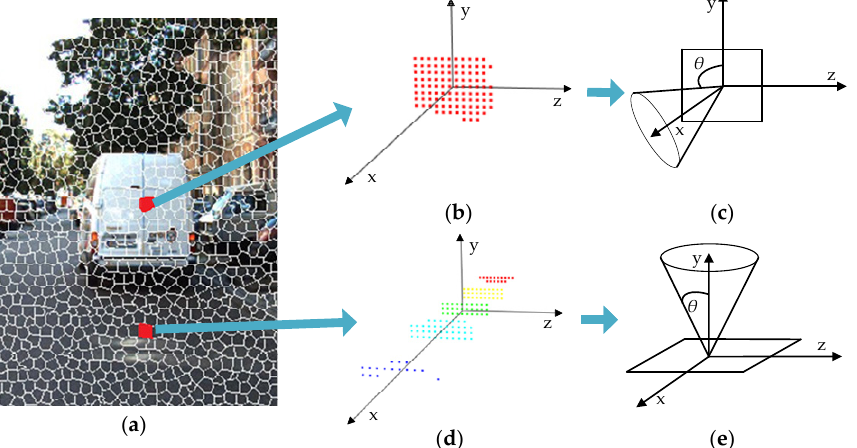
Figure 4. Comparison of point cloud distribution between obstacle and free space area: ( a ) Typical traffic scene; ( b ) Superpixel point cloud distribution in the obstacle area; ( c ) The angle θ between the normal vector of the obstacle area and the y -axis; ( d ) Superpixel point cloud distribution in free space area; ( e ) The angle θ between the normal vector of the free space area and the y -axis.